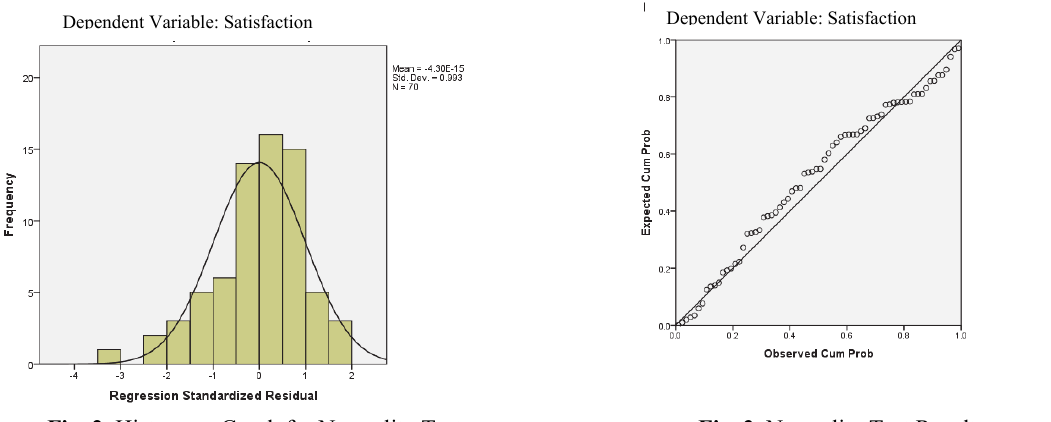
Fig. 2. Histogram Graph for Normality Test Fig. 3. Normality Test Results Source Output SPSS Versi 22